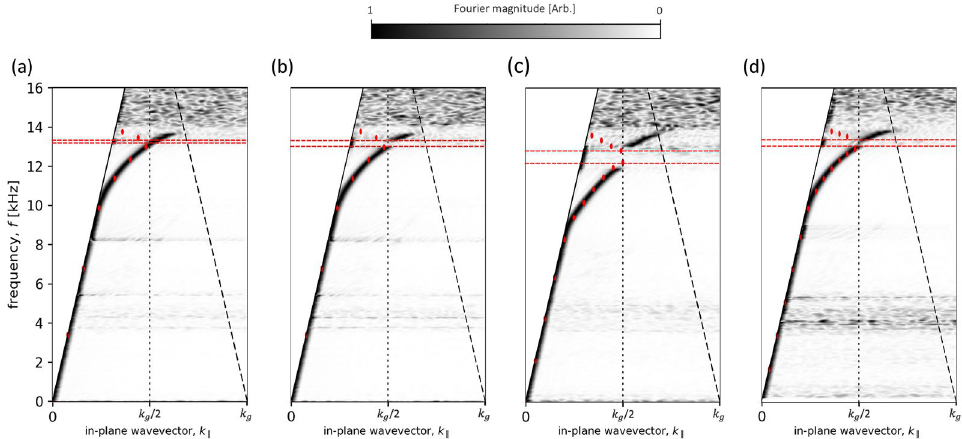
Figure 7. Experimental dispersion diagrams for the sample at a range of translations conditions using a separation, h = 3 mm. ( a ) (cid:31) p / 2 − 0.05 mm x axis translation, ( b ) (cid:31) p / 2 − 0.15 mm x axis translation, ( c ) (cid:31) 2 − 0.35 mm x axis translation and ( d ) (cid:31) 2 − 0.5 mm x axis translation. Absolute Fourier amplitude p / p / is shown as a function of frequency and in-plane wavevector k (cid:31) with the colour representing the Fourier amplitude. Data is normalised using slices in frequency. Solid black lines represent the sound-line ( k 0 ), dashed black lines the diffracted sound-line with vertical dotted lines indicating the first BZB at k � = k g / 2 . Red points show eigenfrequency predictions from a loss-inclusive numerical model. Red dashed lines represent formed bandgaps. The experimental dispersions show a bandgap opening as the x axis translation is increased. However, with ( a ) being such a small displacement, the fit is not exact and the bandgap is not as pronounced. A bandgap is present, indicated by the intensity shift to the sound-line between the two predicted eigenmode